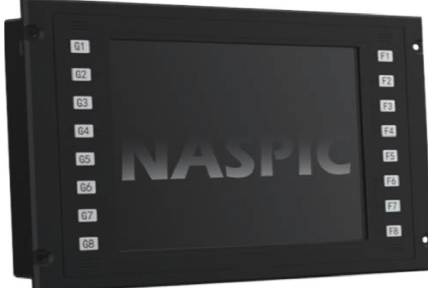
Figure 2: The integrated machine form of